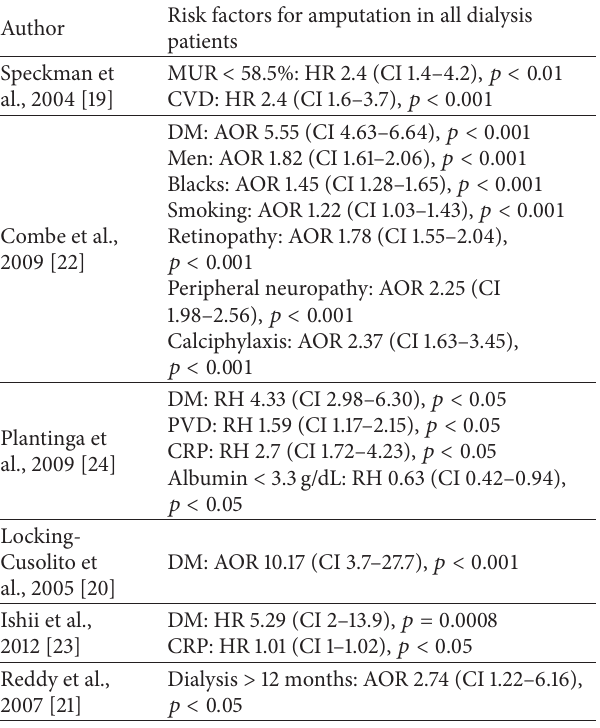
Table 2: Summary of studies assessing risk factors of amputation in subjects on renal